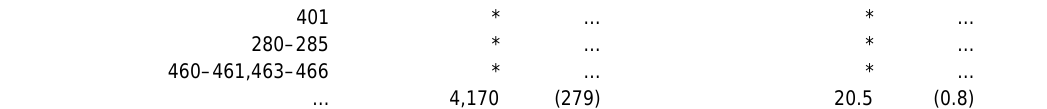
*Figure does not meet standards of reliability or precision. 1 Based on the International Classification of Diseases, Ninth Revision, Clinical Modification (ICD–9–CM) (U.S. Department of Health Services. Centers for Medicare and Medicaid Service. Official version: International Classification of Diseases,